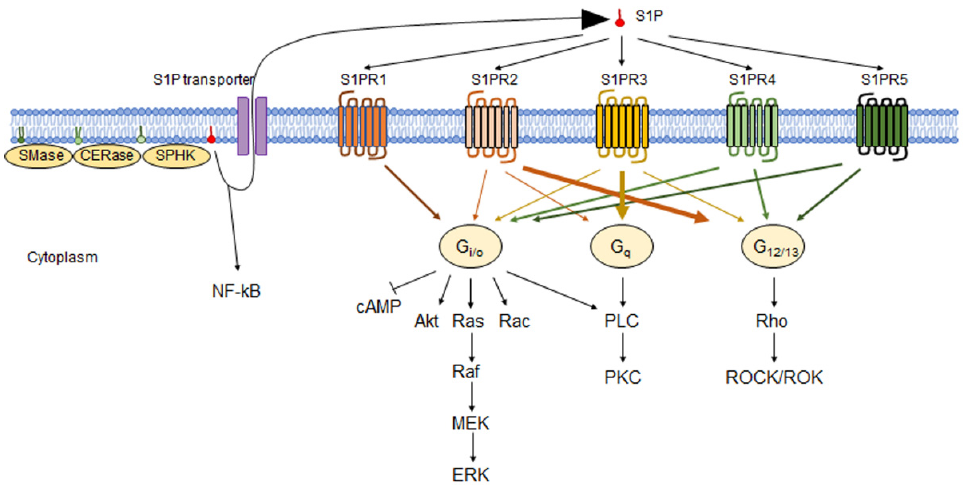
Figure 2. S1P-S1PR pathways. Extracellular S1P binds to S1P receptors. Each receptor binds to a different G protein and triggers downstream signaling pathways. S1PR1 mainly binds to Gi/o, and S1PR2 binds G12/13 and Gi/o and Gq. S1PR3 binds to mostly Gq but also to Gi/o and G12/13. S1PR4 and S1PR5 bind to Gi/o and G12/13. Gi/o activates Akt, Ras-Raf-MEK-ERK, Rac, and PLC/PKC pathways but suppresses cAMP. Gq activates the PLC/PKC pathway. G12/13 activates Rho and the downstream ROCK/ROK